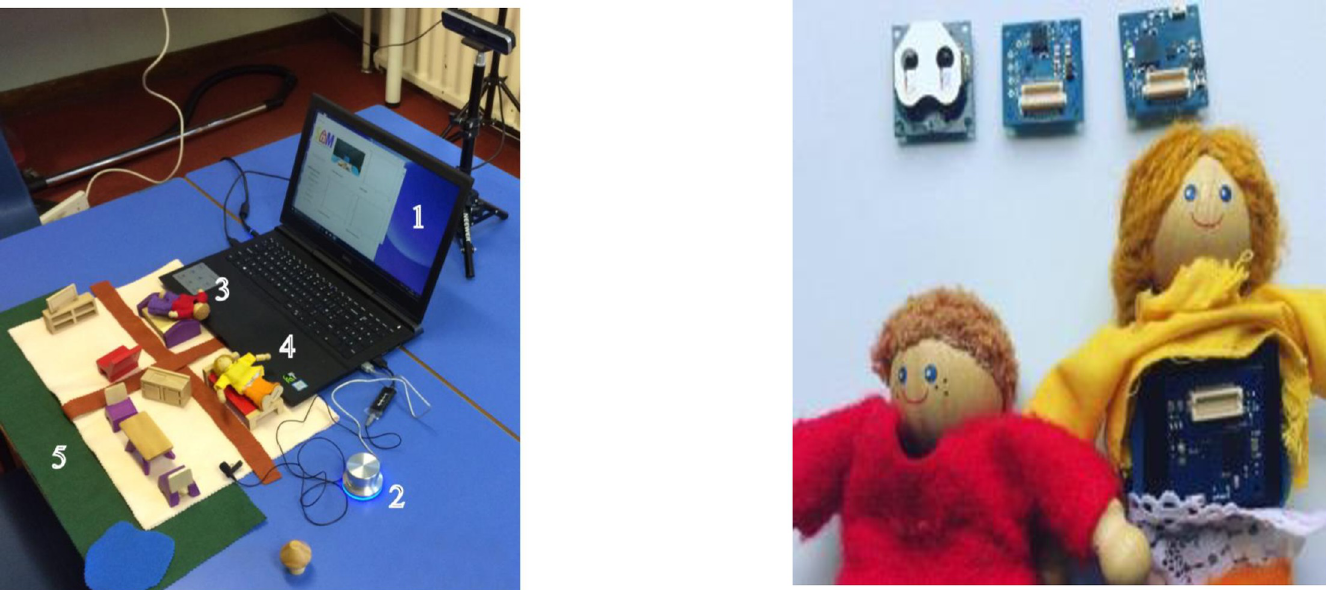
Fig 1. The components of SAM. a. (above left): shows the system as it appears to the users. The computer screen ( 1 ) in the picture) displays the videos with actors guiding the child through the MCAST, the button (2) allows the users to signal the system that they have completed an MCAST step, the dolls ( 3 and 4 ) and the toy house ( 5 ) allow the users to complete the story stems. b. (above right): An image of the dolls that we have designed and installed with sensors inside to enable administration and machine-learning based ratings.